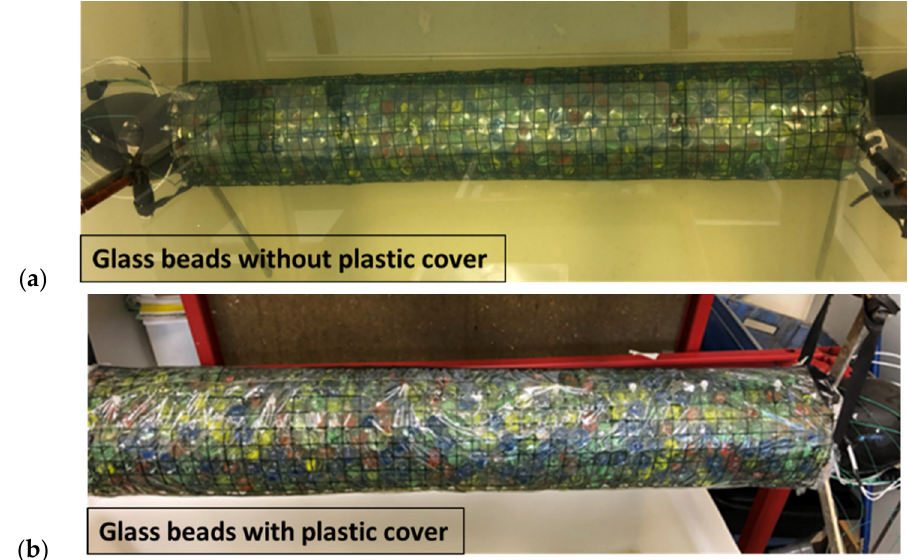
Figure 9. Experimental tube covered with glass beads ( a ) without plastic cover ( b ) with plastic